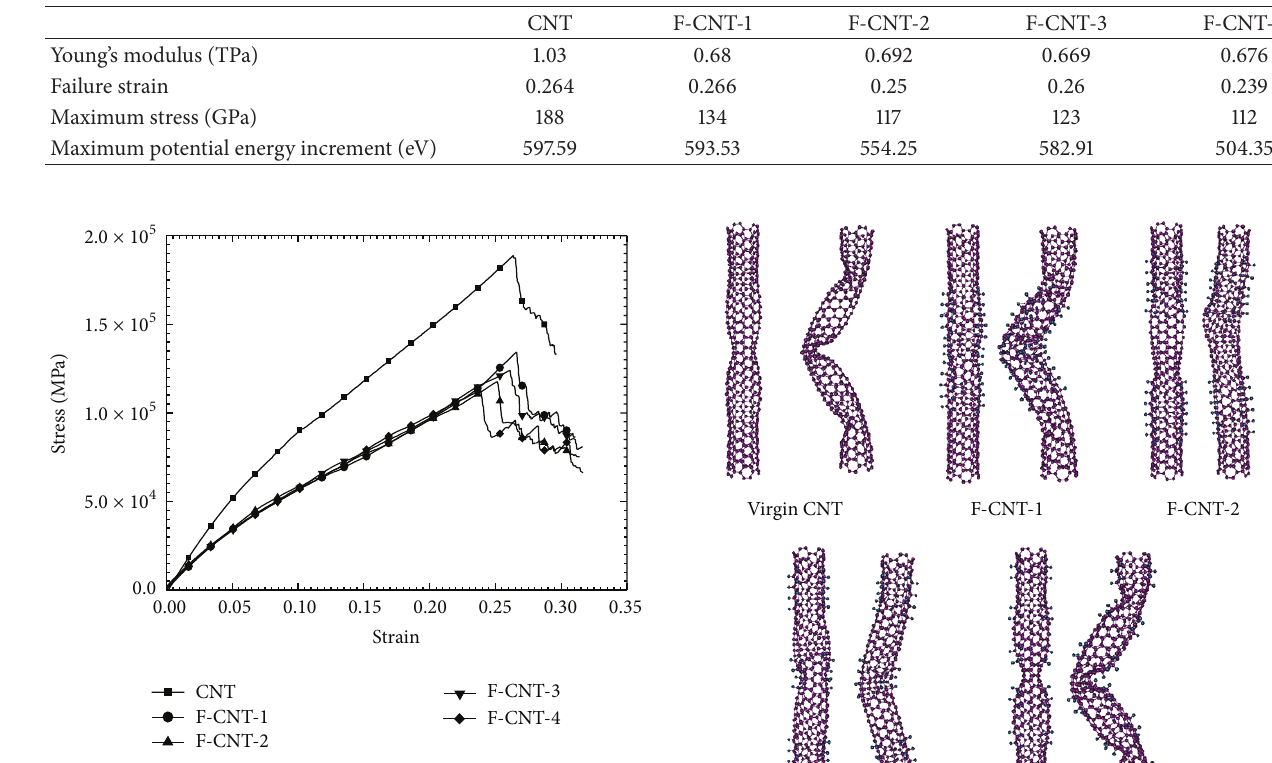
Table 1: Tensile properties of F-CNTs with different functionalized configurations.